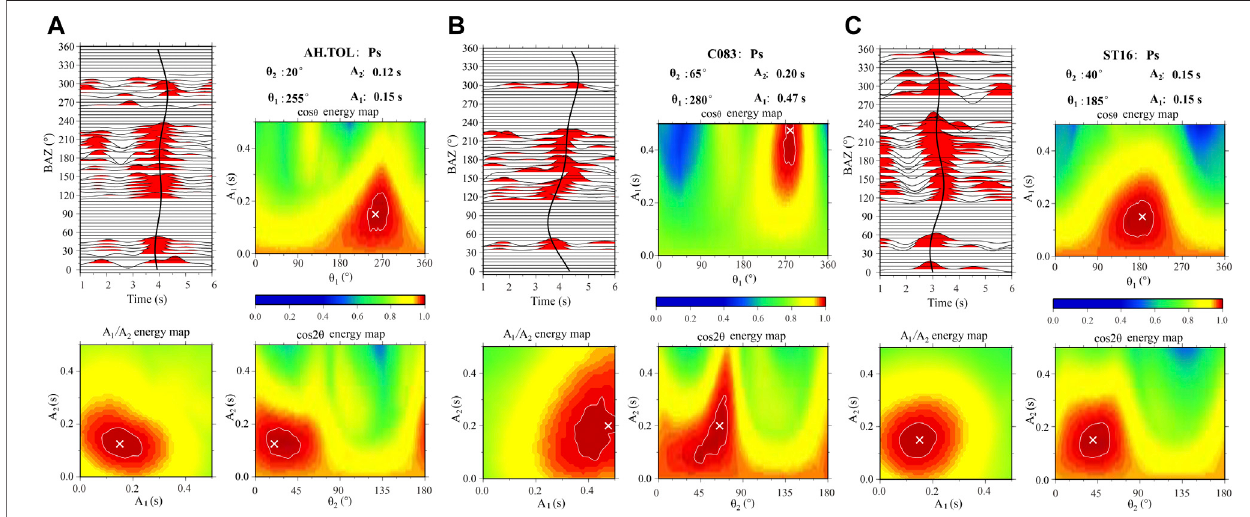
FIGURE 4 | Pms fi tting results of three stations AH.TOL (A) , C083 (B) and ST16 (C) . The black lines represent the arrival times of Pms, the crosses mark indicate the best solutions, and the 99% contours to show the empirical uncertainty.